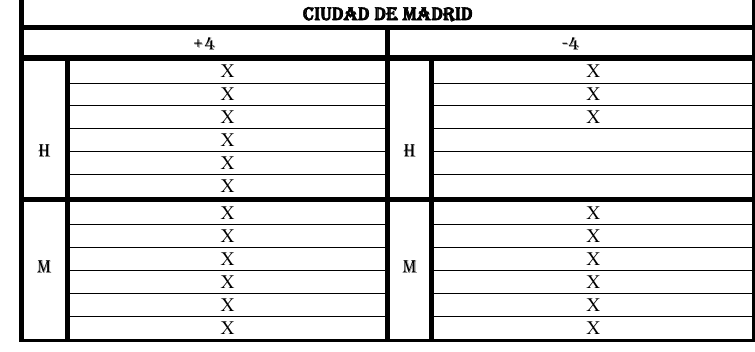
Languages 2020 , 5 , x FOR PEER REVIEW Figure 2. Data on the informants surveyed in the city of Madrid. Figure 2. Data on the informants surveyed in the city of Madrid.